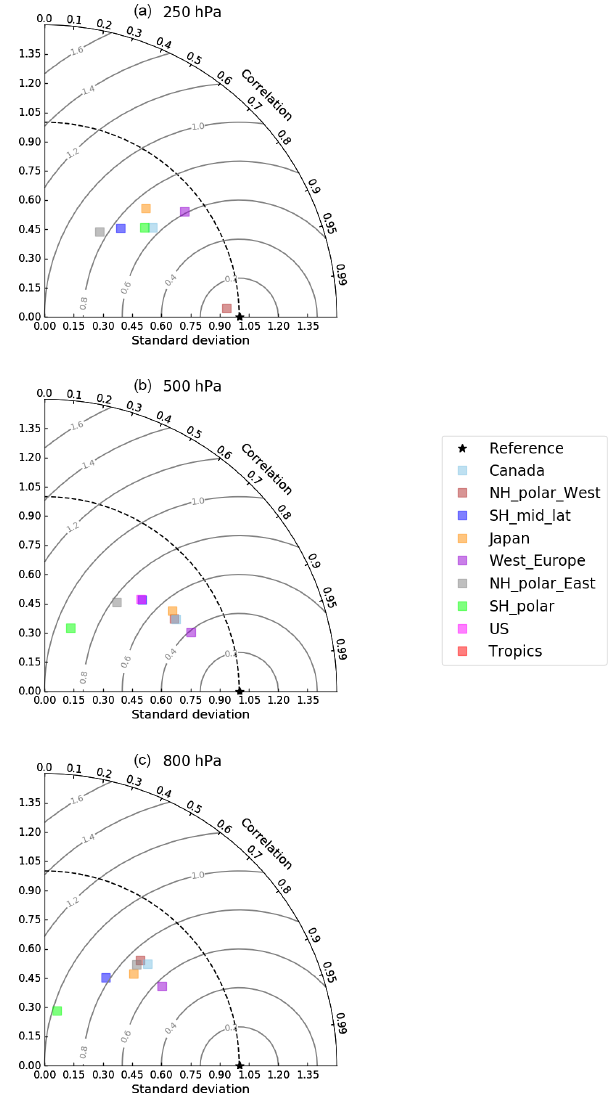
Figure 7. Taylor plots of regional averaged ozonesondes at 250hPa (a) , 500hPa (b) , and 800hPa (c) . Ozonesonde data and re- gion definitions are from Tilmes et al. (2012). Where a region is not shown in a panel, the respective data point is outside the axis